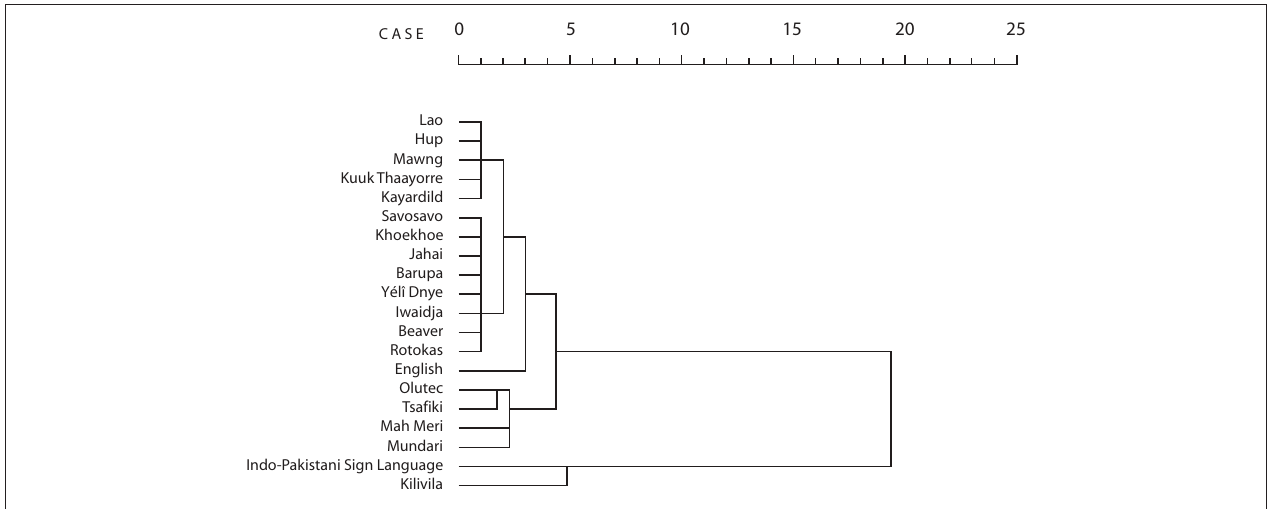
FigurE 4 | Cluster analysis of languages overall pattern of categorization of reciprocal